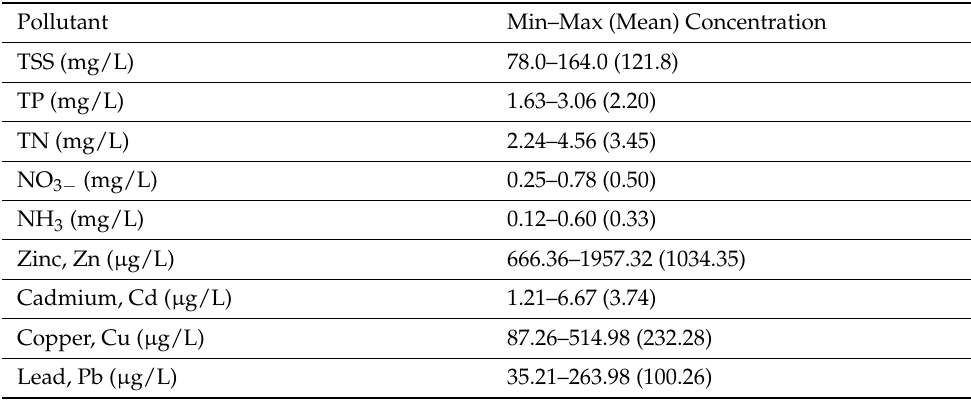
Table A3. Characteristics of stormwater runoff used for Phase